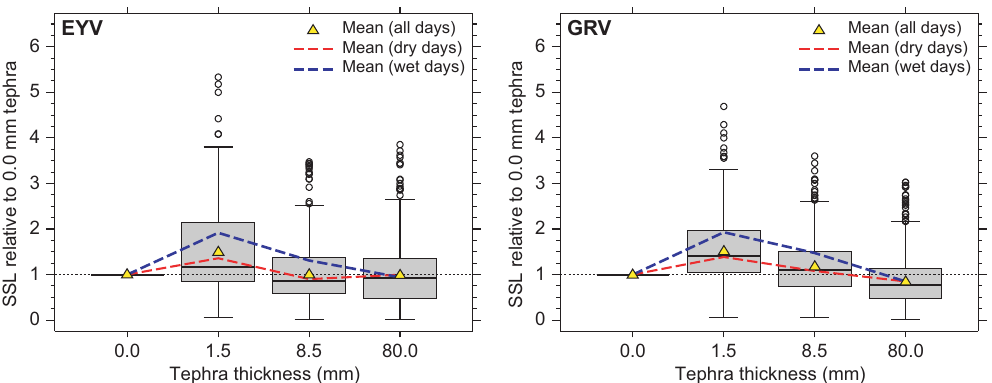
Figure 4. Running 24h snow-surface lowering (SSL) rates at the different plots of tephra from Eyjafjallajökull volcano (EYV) and from Grímsvötn volcano (GRV) relative to the reduction rates measured at the non-tephra covered reference site. The box plots give an overview of the data spread across all running 24h values recorded during the field experiment period (15 June to 3 August). Outliers are indicated as open circle symbols. Mean values over the entire field experiment period are indicated by yellow triangles, and the mean values over wet (precipitation > 0.1mm) and dry (precipitation ≤ 0.1mm) days are shown as color-coded line